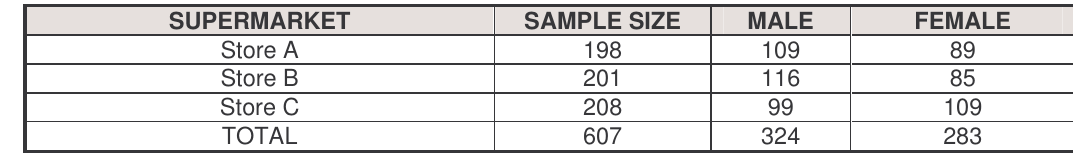
Table 1: Sample size and